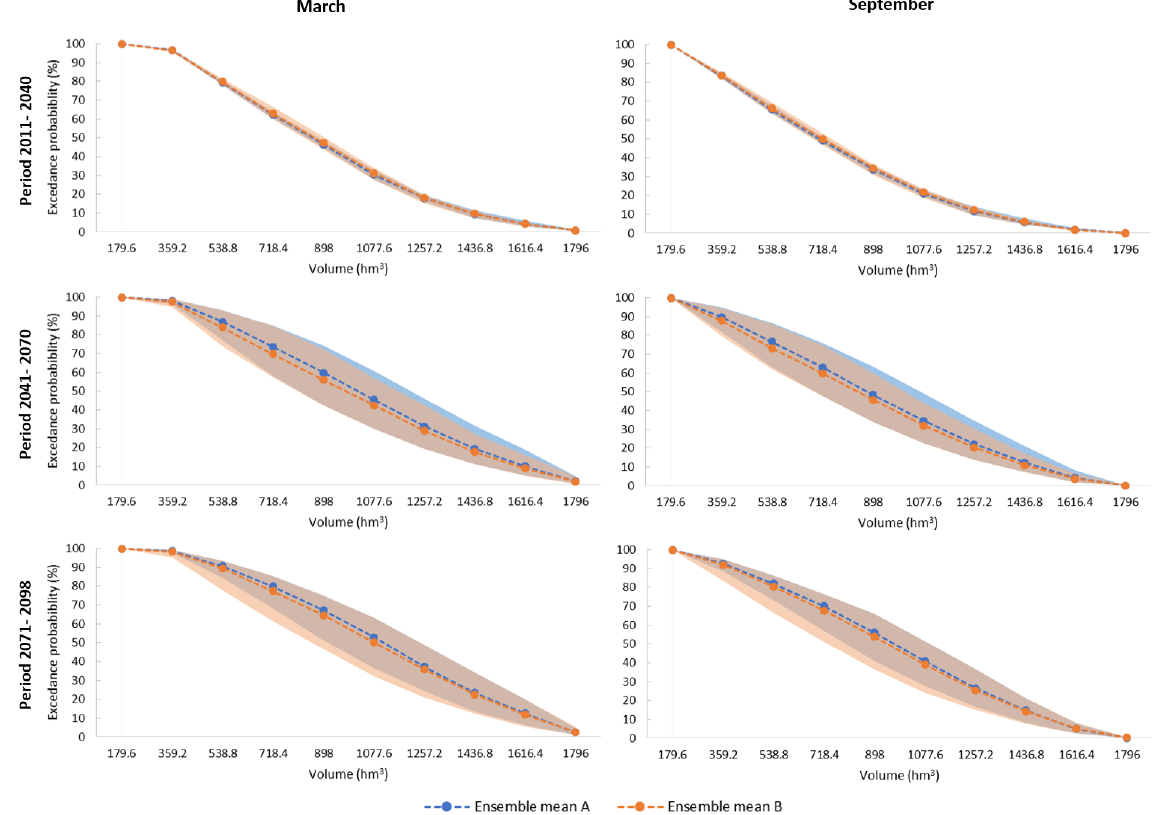
Figure 9. Exceedance probability of the ensembles (shaded areas) coming from options A and B in the start (March) and the end (September) of the irrigation season for the future periods 2011–2040, 2041–2070, and